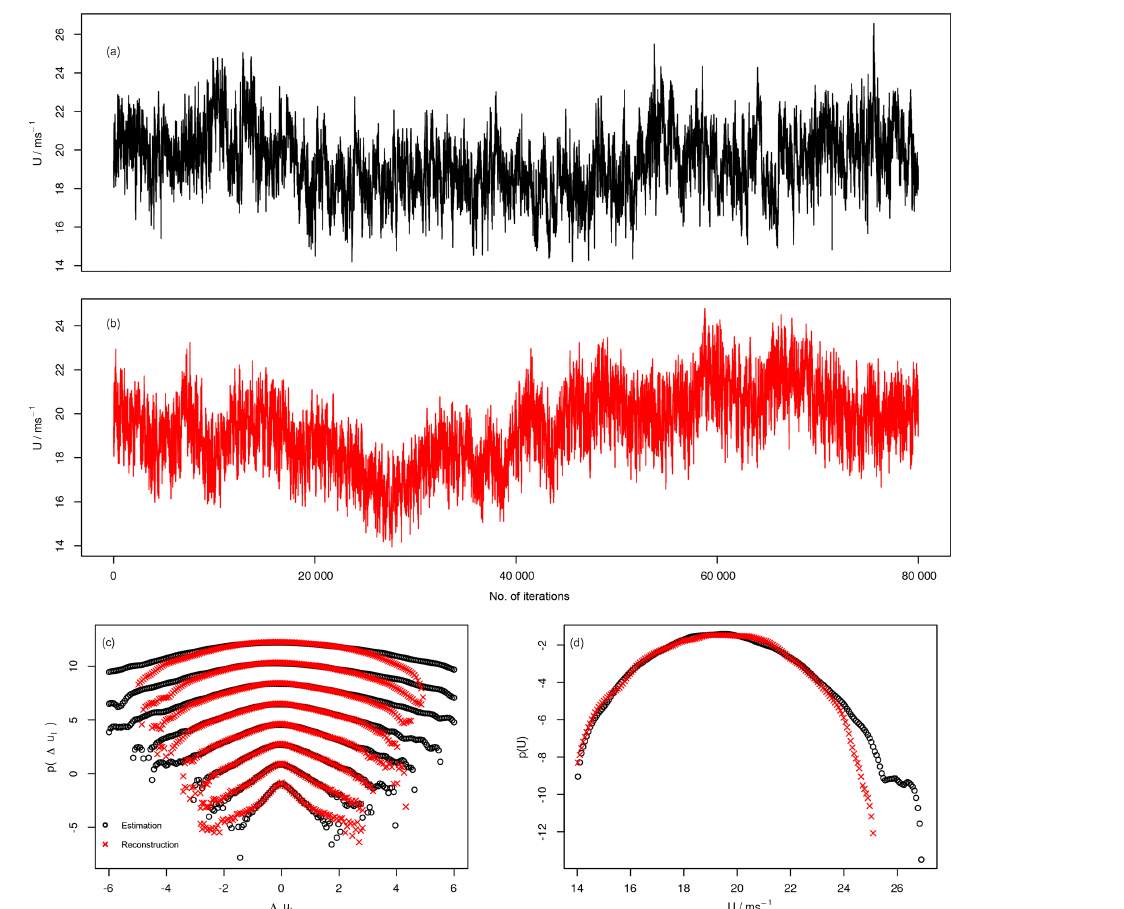
Figure 9. (a, b) Comparison between measured non-stationary speeds U and reconstructed non-stationary wind speeds. (c, d) Increment and one point pdf’s of original and reconstructed U